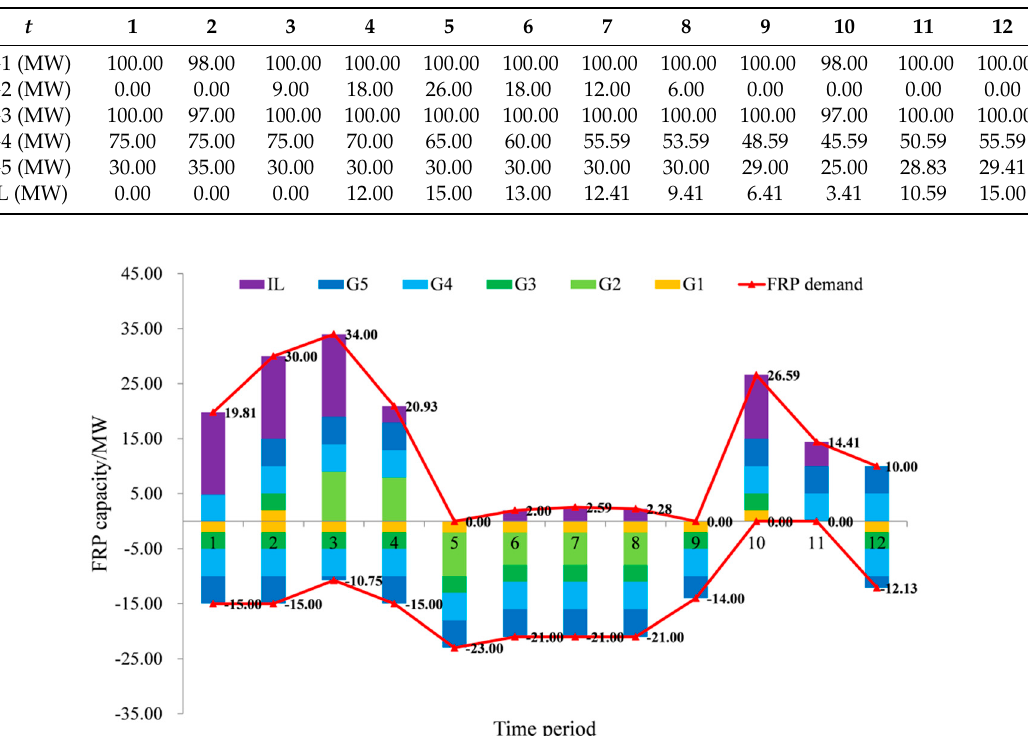
Table 5. Actual power outputs of generating units and interruptible load (IL) where β = 0.9 and R ac = 1500.